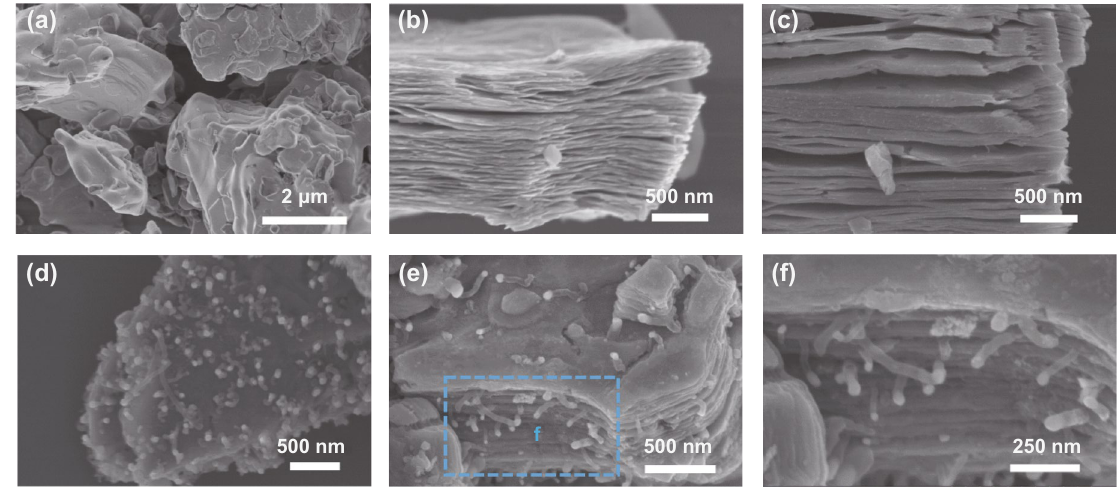
Fig. 2 SEM images of a MAX, b MXene, c MXene-alk, and d–f